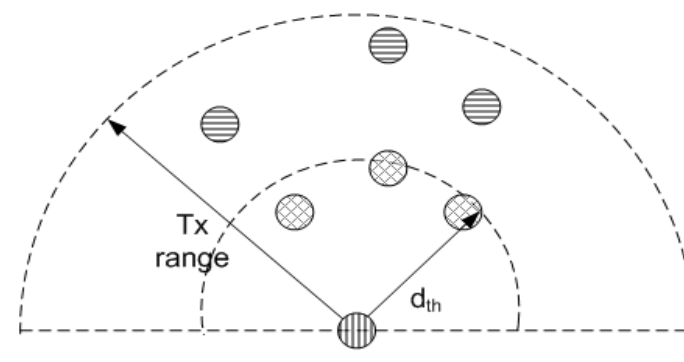
Figure 3. Depth thresholds based on number of